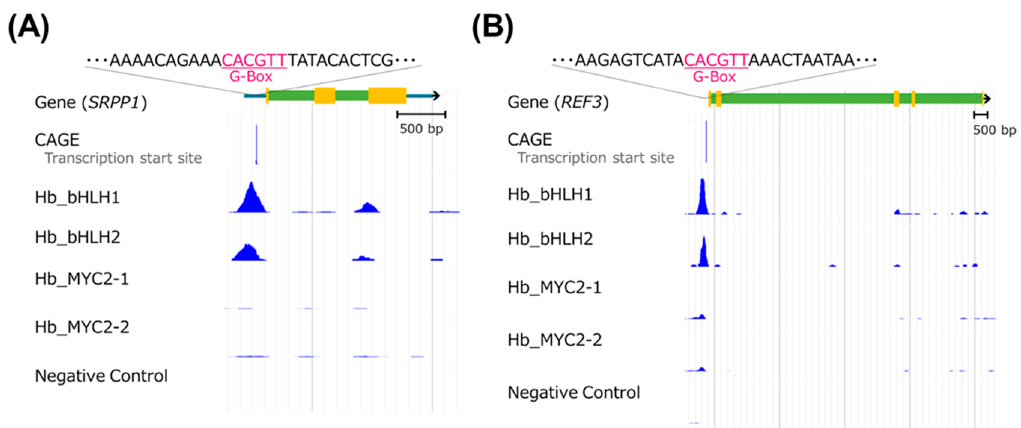
Figure 6. Genome browser view of SRPP1 and REF3 loci. Hb_bHLH1 and Hb_bHLH2 physically bind upstream of the transcription start sites (CAGE) of SRPP1 ( A ) and REF3 ( B ). Both binding regions contain a G-box sequence, which is the binding motif of bHLH TFs.